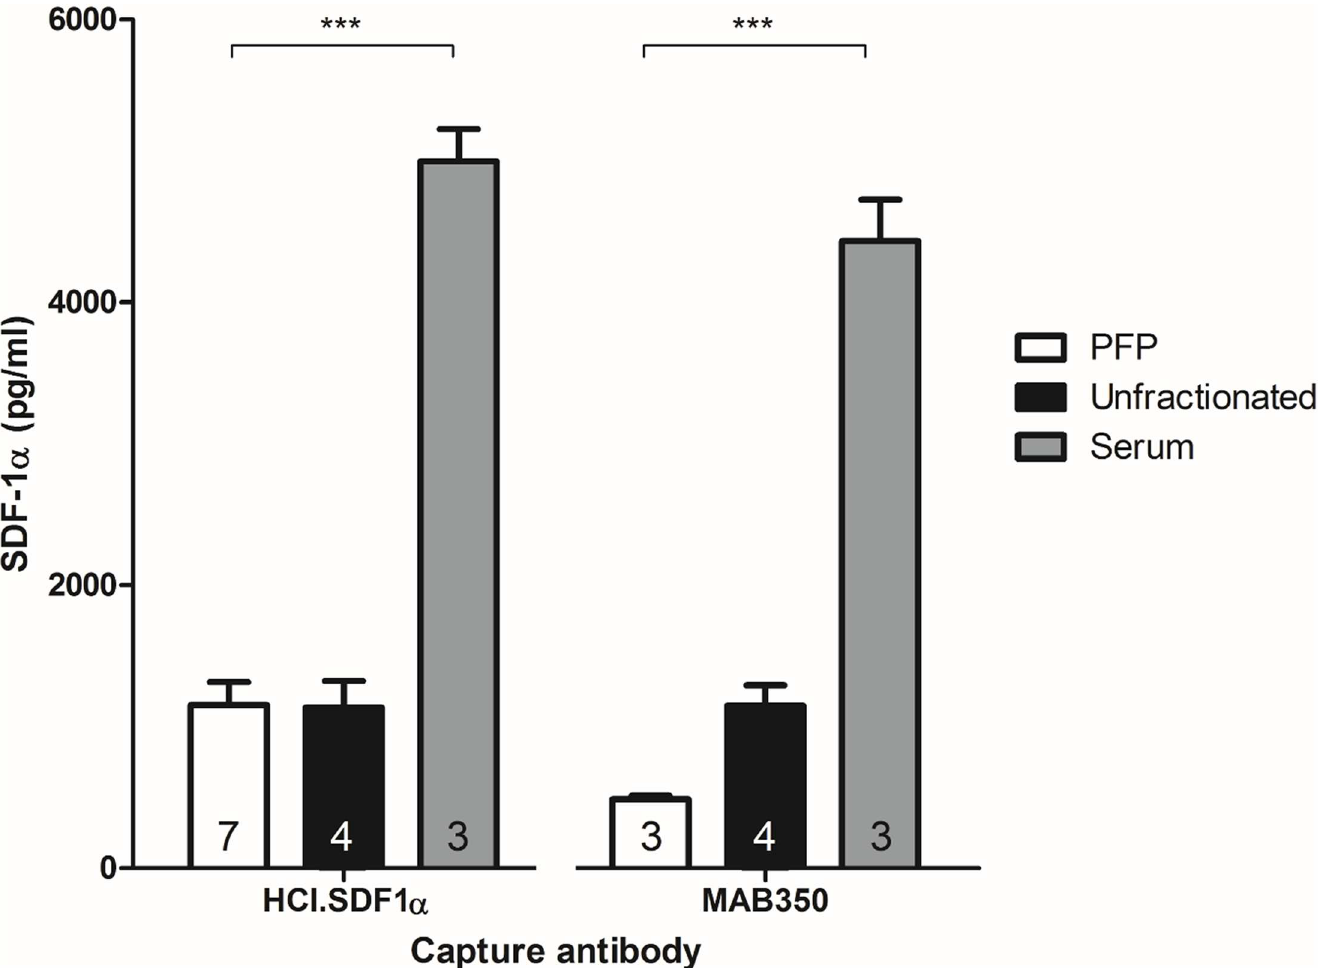
Fig 8. The effect of sample type on SDF-1 α concentration. Serum samples, collectedby allowingwhole blood to clot for 10 min prior to centrifuging to remove the clot, had significantly more active SDF-1 α than either platelet-free (PFP) or unfractionated plasma samples that were collectedinto a citrated tube and preparedby differentialcentrifugation, when measuredusing either capture antibody as